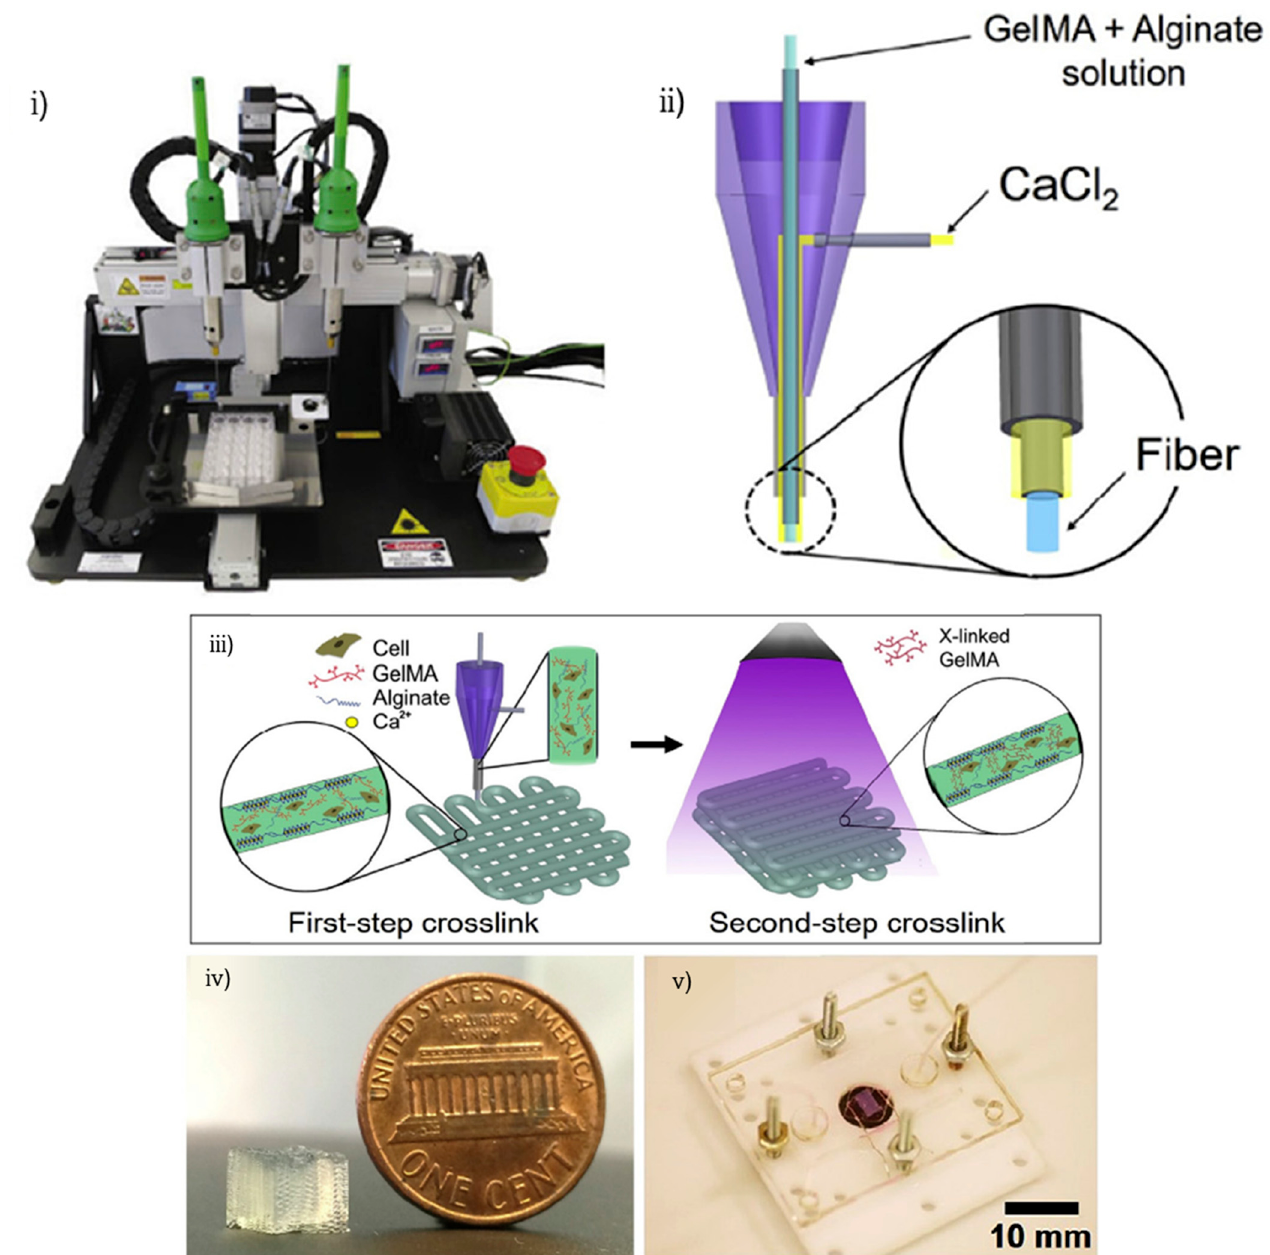
Figure 6. Bioprinted heart-on-a-chip in a microfluidic ( i ) commercial bioprinter Organovo Novogen MMX, ( ii ) printing nozzle schematic, ( iii ) crosslinking process schematic, ( iv ) photograph of a bi-